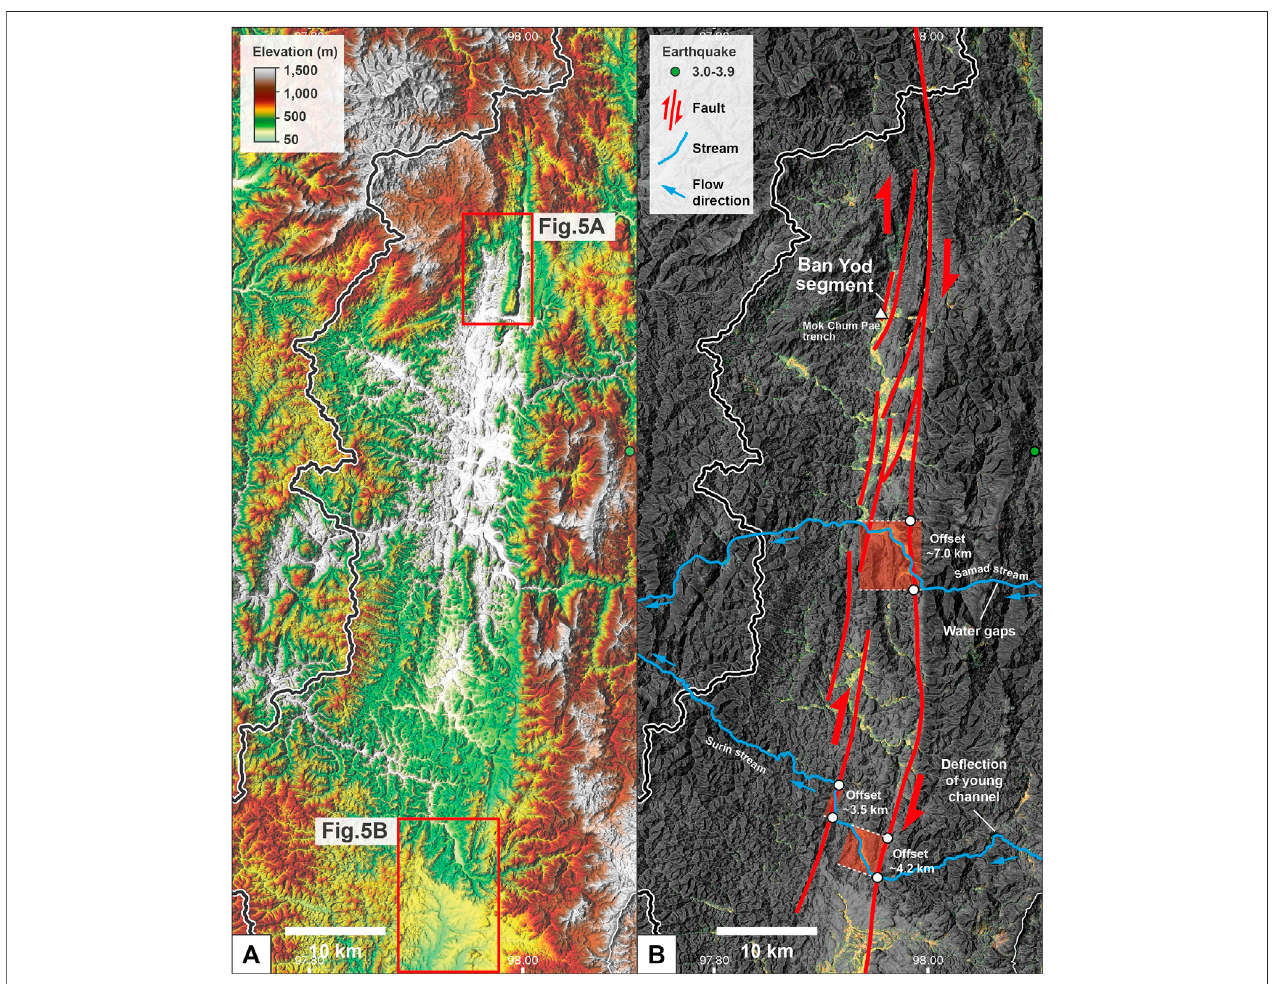
FIGURE 3 | Mae Hong Son Basin on the north side of Mae Hong Son Province is shown as an (A) enhanced ALOS DEM, and (B) detailed interpretation at the Samadstreamdisplaysoffsetstreamwithmaximumoffsetof~7.0 kmsuggestingtheright-lateralstrike-slipfaultmovementandattheSurinstreamshowsoffsetstream of ~3.5 and ~4.2 km (maximum offset ~7.7 km) also suggesting the right lateral strike-slip fault movement. Locations are shown in Figure 2A .